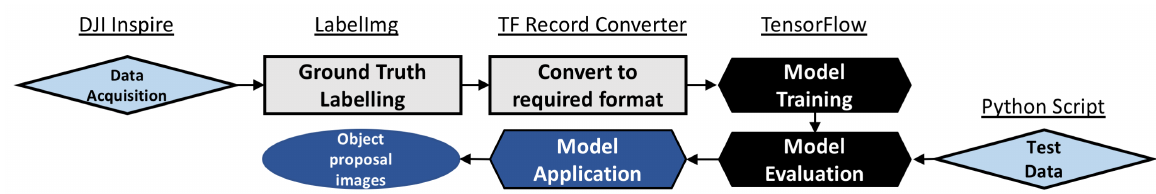
Figure 2: Workflow for training CNN with user acquired data. Test data is all the user data acquired that was not included in the training or validation